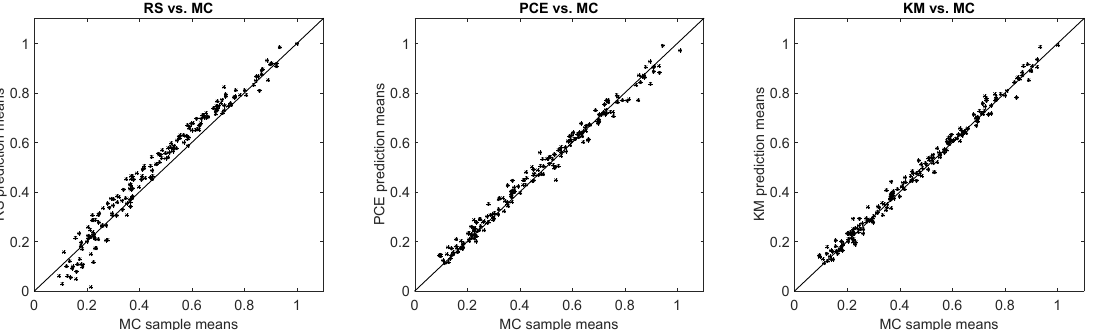
Figure 6. y − y plots comparing the blade root flapwise 1Hz damage-equivalent load (DEL) predictions for three load surrogate models – quadratic Response Surface, Polynomial Chaos expansion, and Kriging model, compared against site-specific Monte Carlo (MC) simulation. The x axis represents the loads obtained using site-specific MC simulations for reference site 0, and the y axis represents the mean 1Hz- equivalent load estimated for the same sample points using a surrogate model. All values are normalized with the maximum equivalent load attained from the site-specific Monte Carlo (MC) simulation.